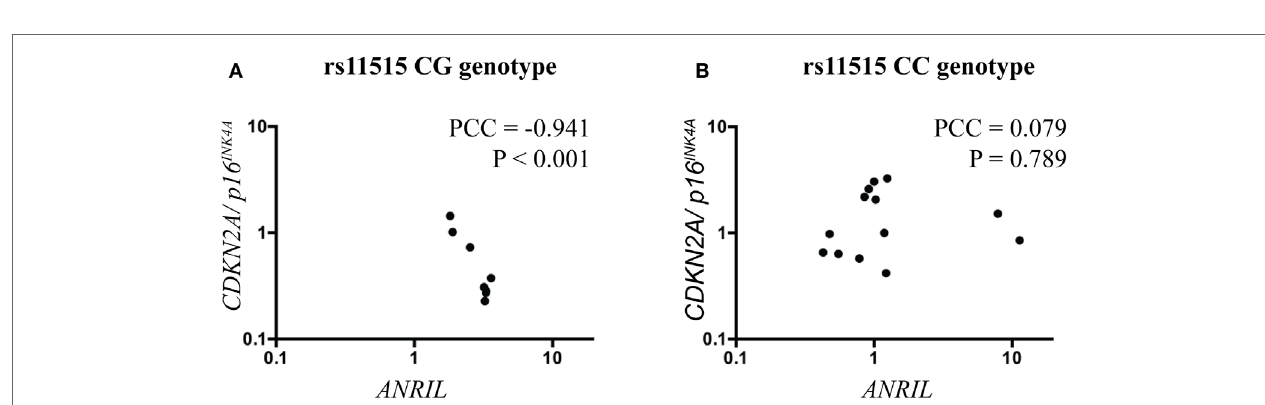
FigUre 2 | scatterplots illustrating the interaction between rs11515 genotypes and ANRIL on CDKN2A/p16 INK4a gene expression in breast tumor samples. (a) In tumors with a CG genotype, ANRIL and CDKN2A/p16 INK4a levels were strongly negatively correlated. (B) In contrast, in tumors with a CC genotype, ANRIL and CDKN2A/p16 INK4a levels were not correlated. PCC = Pearson correlation coefficient.